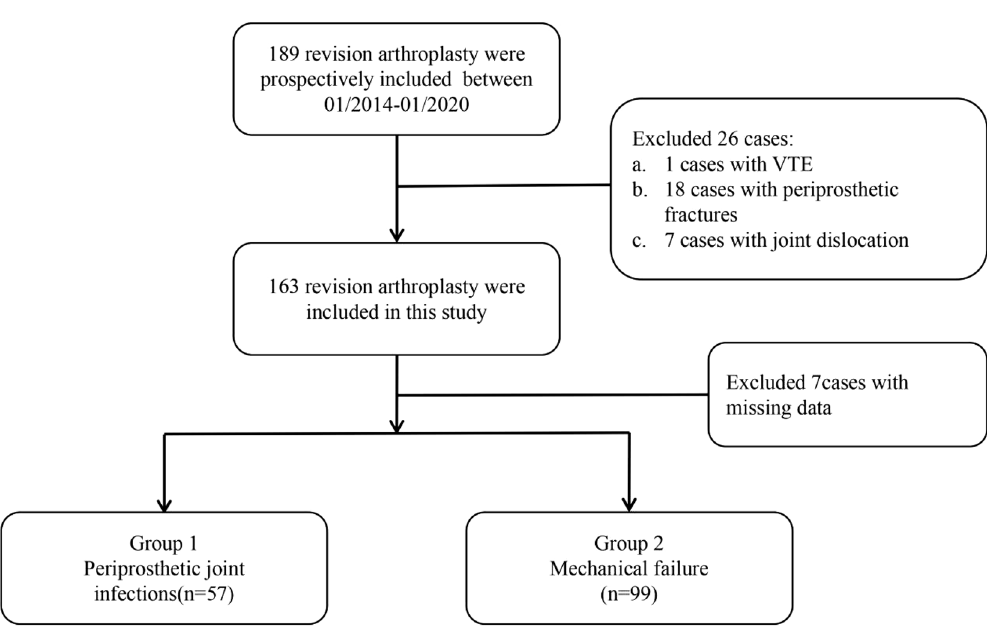
Figure 1. The inclusion and exclusion criteria of patients in the study